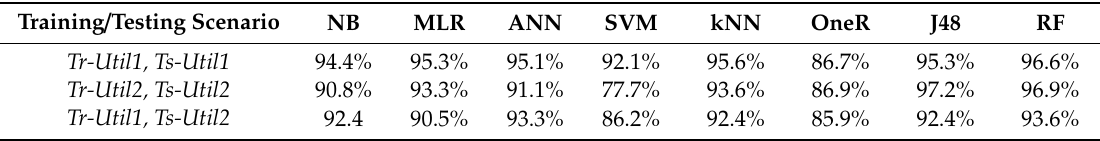
Table 5. Summary of reduced-feature MAR results.